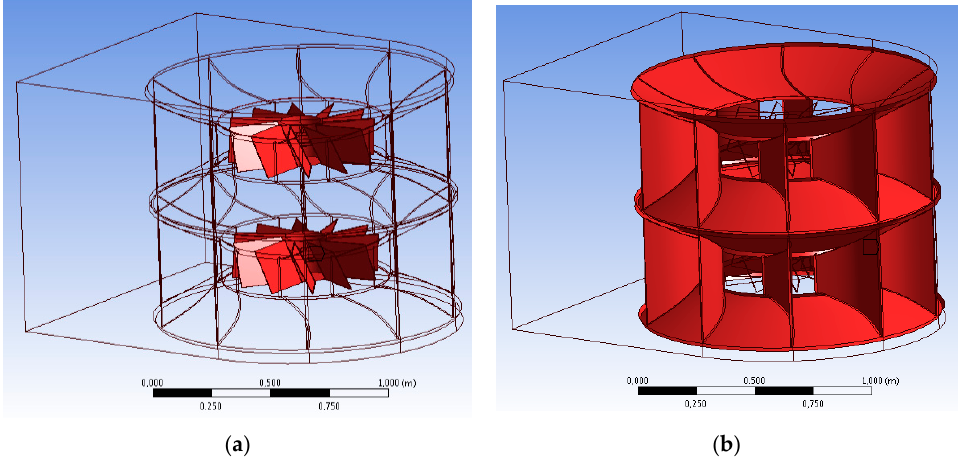
Figure 3. ( a ) Rotor; ( b ) stator of two-stage wind turbine KIONAS and computational domain.